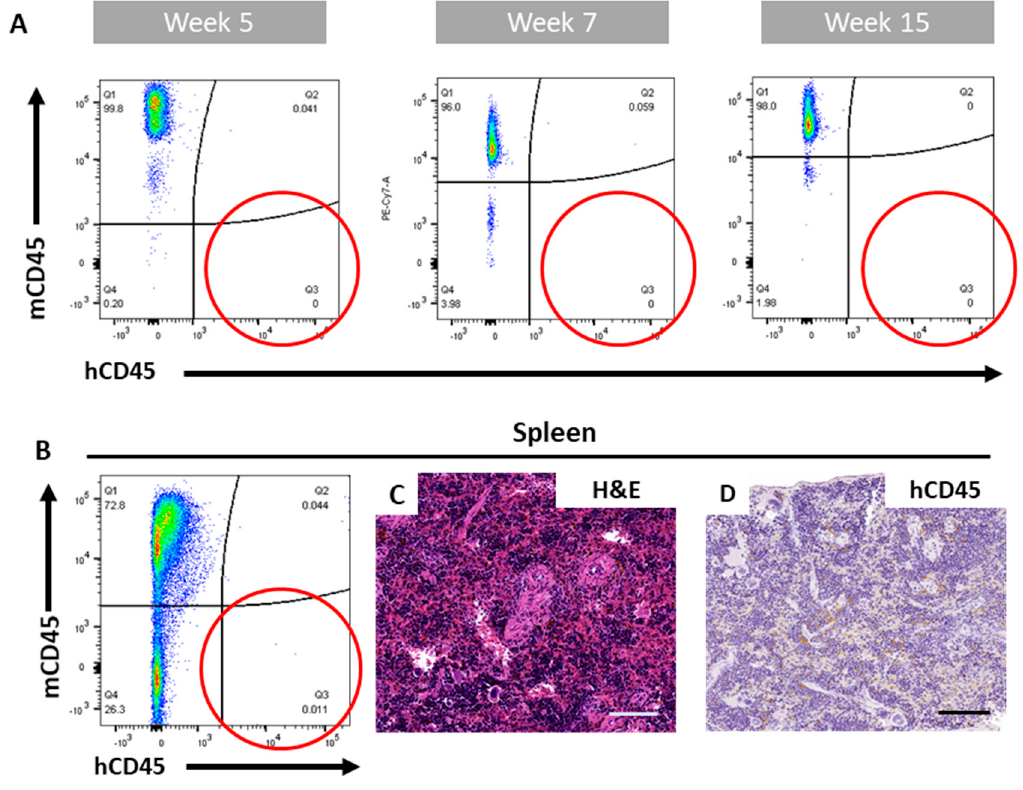
Figure 6. BM-derived CD34 + cells from an exemplary multiple myeloma (MM) patient did not engraft when implanting 50,000 cells. Flow cytometry of peripheral blood at weeks 5, 7 and 15 showed no hCD45 + circulating cells ( A ). No human cells migrated to the spleen, as demonstrated by flow cytometry analysis ( B ). Histological analysis demonstrated a normal spleen morphology, as shown by H&E ( C ) and no migration of hCD45 + cells ( D ). Scale bars: 100 µm.